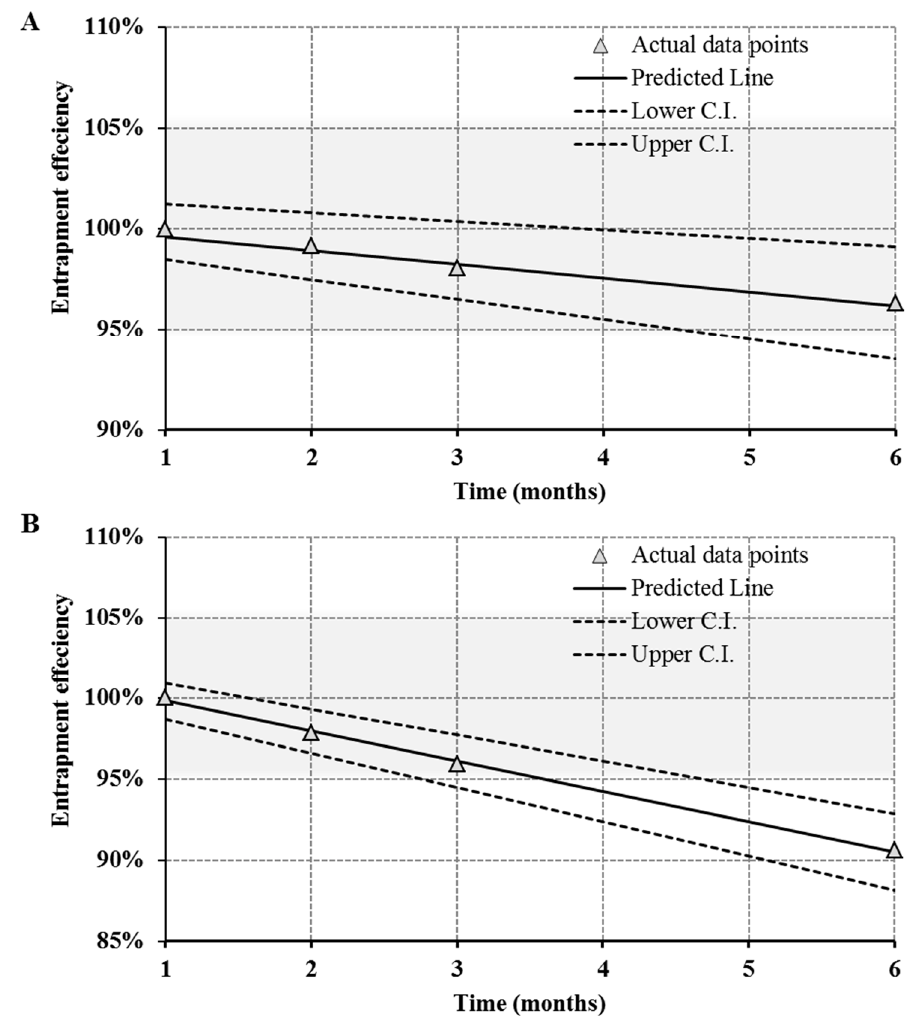
Figure 8. Shelf-life estimation of the RLX-solid lipid nanoparticles (SLNs) ( A ) at 4 ◦ C and ( B ) at 25 ◦ C ± 2 ◦ C and 60% ± 5% RH. Dotted line shows the 95% confidence interval limits.